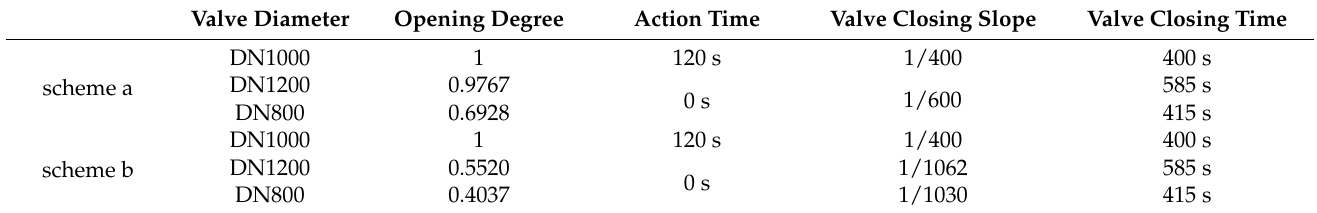
Table 1. Valve opening and closing rules for schemes a and b.